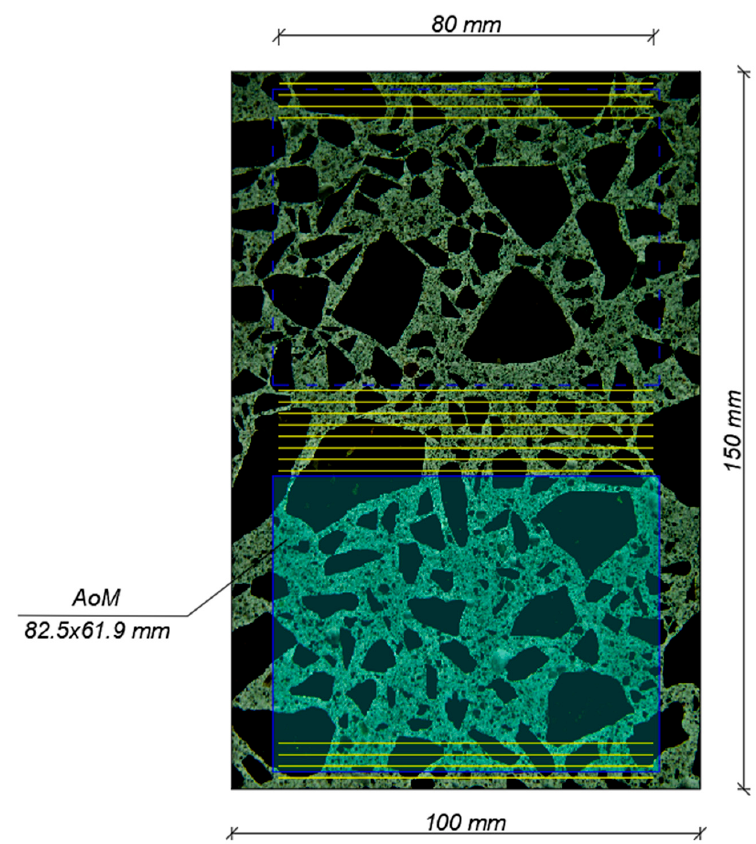
Figure 1. The arrangement of 16 traverse lines (1D) and area of measurement (2D).